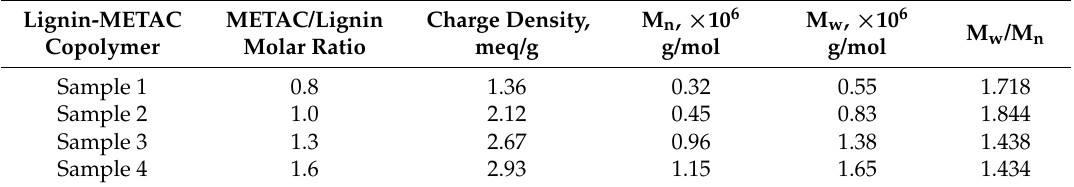
Table 1. Reaction conditions and physical properties of Lignin-METAC